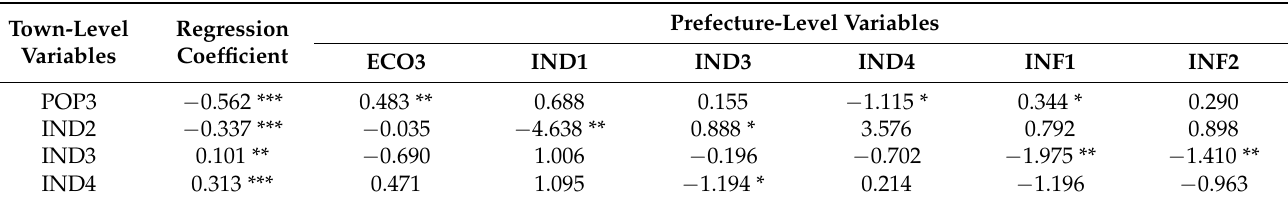
Table 5. The cross-level impact of prefecture-level cities on ordinary towns.